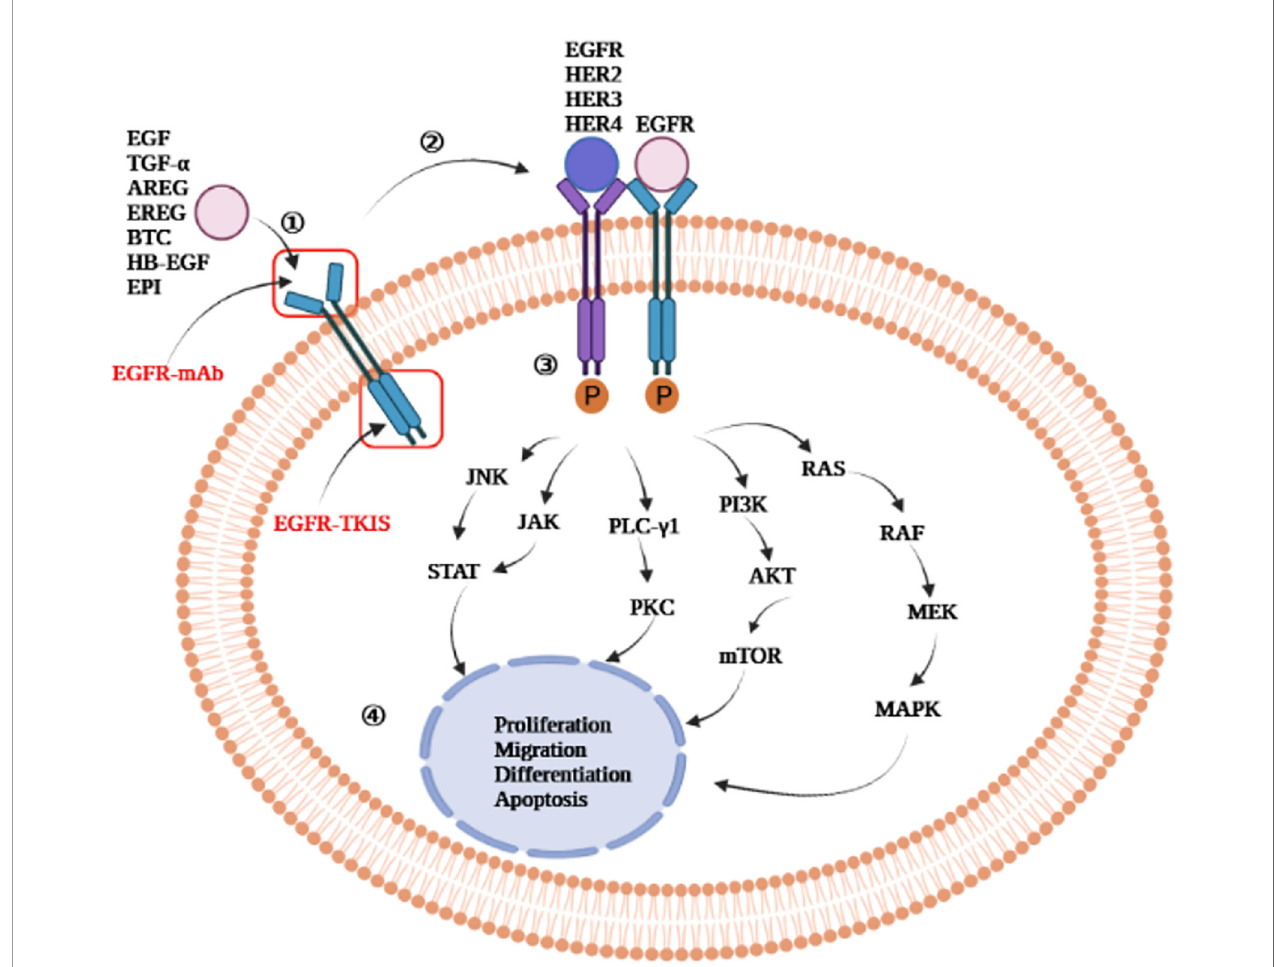
FIGURE 2 | Epidermal growth factor receptor activation mechanism. EGFR-mAb: Cetuximab, panitumumab, zalutumumab, nimotuzumab; EGFR-TKIs: ge fi tinib, erlotinib, lapatinib, icotinib, neratinib, dacomitinib, afatinib, olmutinib, osimertinib, furmonertinib mesylate, brigatinib; JNK, jun amino-terminal kinase; JAK, janus activated kinase; STAT, signal transducer and activator of transcription; PLC- g 1, phospholipase C- g 1; PKC, protein kinase C; MAPK, mitogen-activated protein kinase; PI3K, phosphatidylinositol-3- kinase; mTOR, mammalian target of rapamycin; AKT, protein kinase B; RAS, rat sarcoma virus gene homolog; RAF, rapidly accelerated fi brosarcoma serine/threonine kinase; MEK, mitogen-activated protein kinase kinase; ERK, extracellular signal- regulated kinase; EGF, epidermal growth factor; TGF- a , transforming growth factor- a ; AREG, amphiregulin; EREG, epiregulin; BTC, betacellulin; HB-EGF, heparin binding epidermal growth factor-like growth factor; EPI, epiregulin; EGFR, epidermal growth factor receptor; HER, human epidermal growth factor receptor; mAb, monoclonal antibody; TKIs, tyrosine kinase